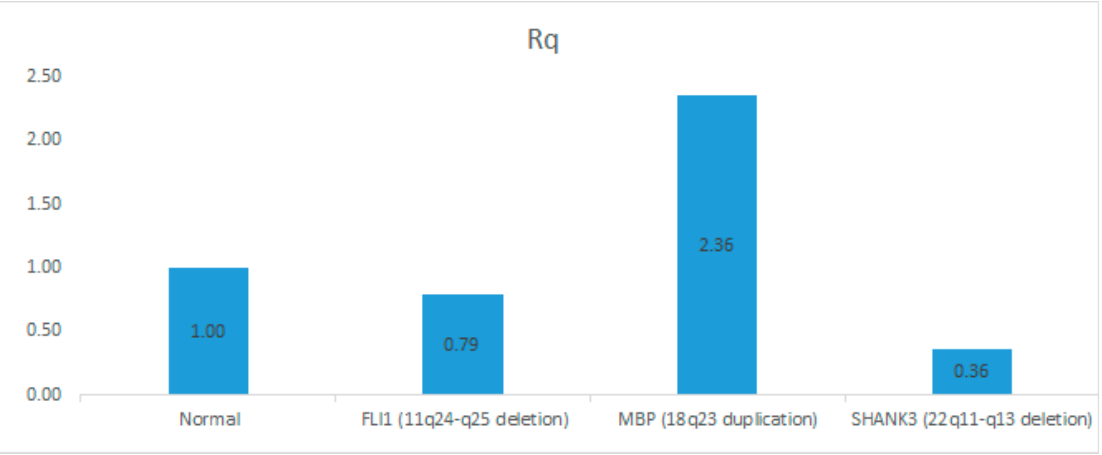
Figure 5. Con fi rmation of CNVs by qPCR: Bar graph showing a signi fi cant decrease in copy number Figure 5. Confirmation of CNVs by qPCR: Bar graph showing a significant decrease in copy number of FLI1 and SHANK3 , and a signi fi cant increase in MBP. of FLI1 and SHANK3 , and a significant increase in MBP